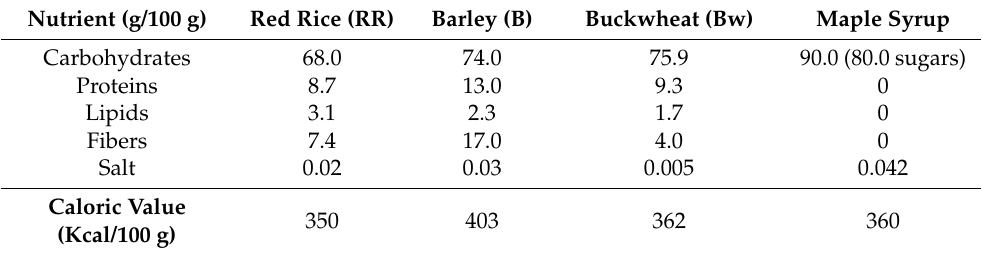
Table 2. Nutritional label of the three commercially available grains and maple syrup purchased